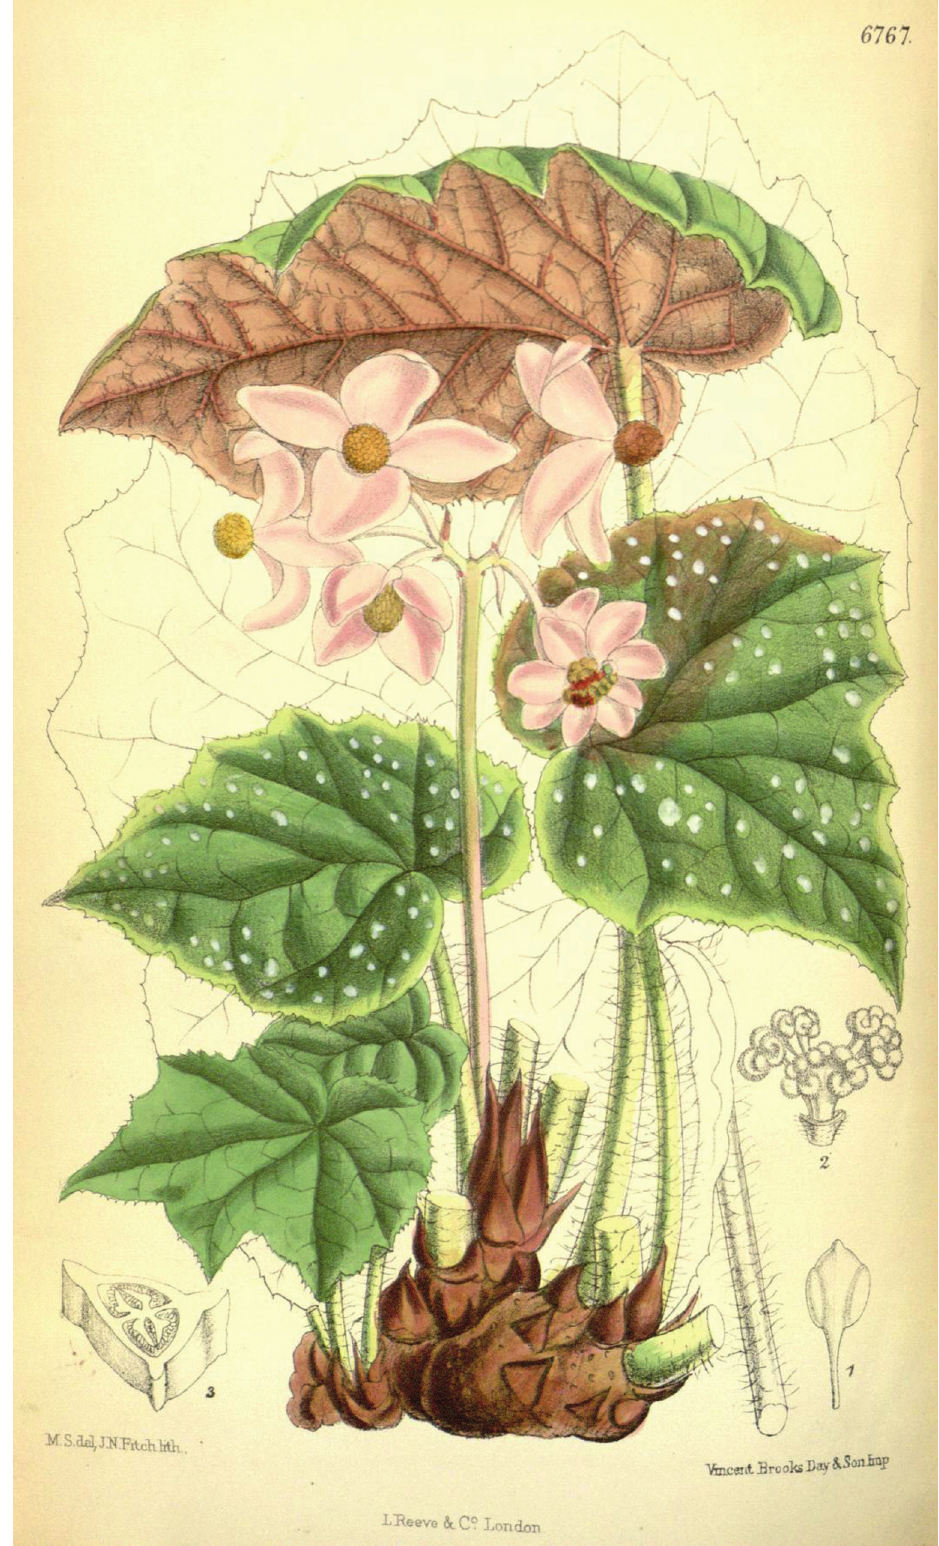
Fig. 13. Illustration of B. beddomei Hook.f. by M. Smith (Hooker 1884). 1. Stamen. 2. Styles. 3. Fruit cross-section. Image from the Biodiversity Heritage Library, digitized by the Peter H. Raven